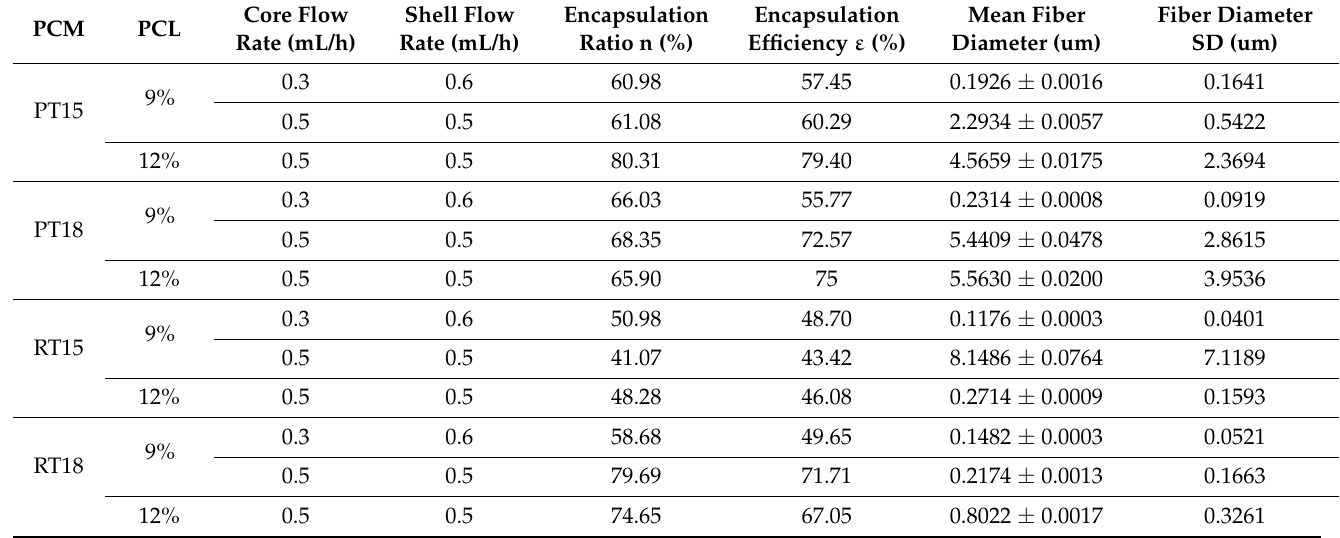
Table 5. Encapsulation ratio, efficiency and mean diameters of encapsulated electrospun